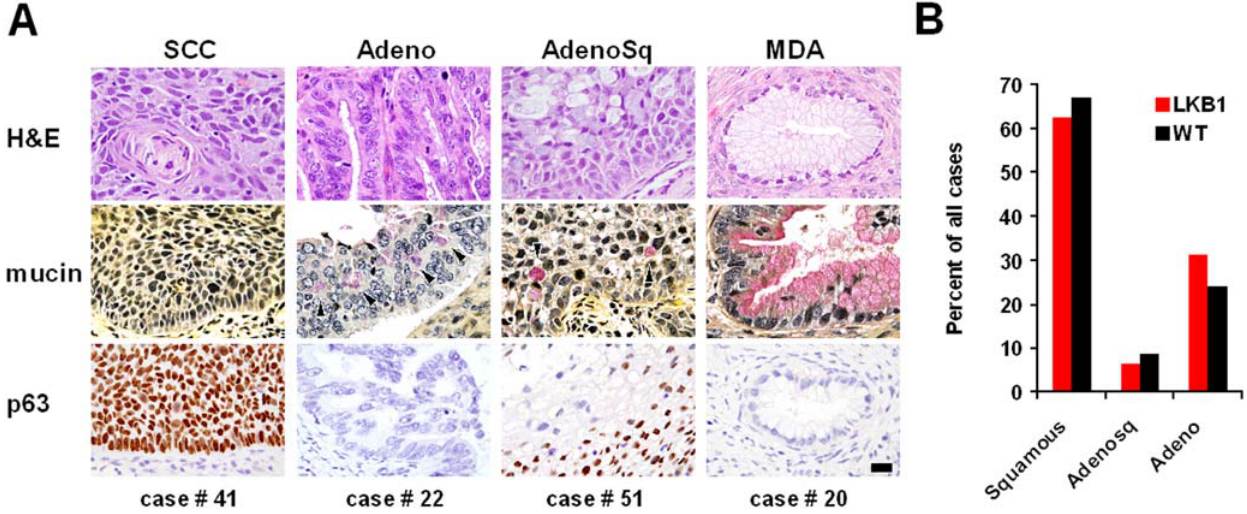
Figure 2. LKB1 mutations occur in each of the principal histologic subtypes of cervical cancer. (A) Histology of representative cases with LKB1 mutations (SCC=squamous cell carcinoma; Adeno=adenocarcinoma; AdenoSq=adenosquamous carcinoma; MDA=minimal deviation adenocarcinoma). Scale bar=20 microns. (B) Relative distribution of the three principal histologic subtypes among LKB1 -mutant (red) vs. LKB1 -wild type (black) cases (totals=100%) shows that the histologic spectrum is virtually identical in LKB1 null vs. wild-type tumors.